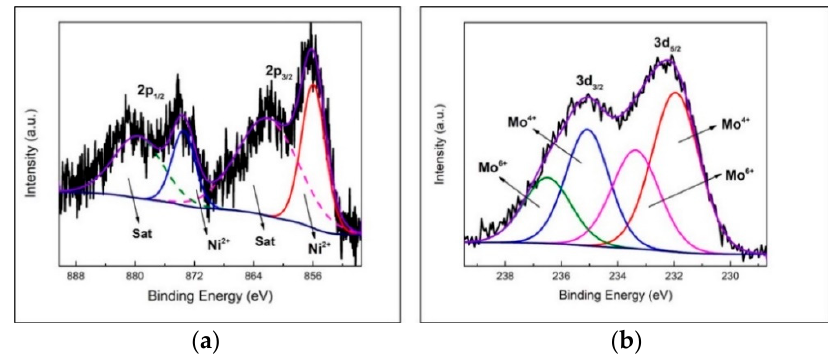
Figure 6. High ‐ resolution XPS spectra of ( a ) Mo 3d, ( b ) Ni 2p. Figure 6. High-resolution XPS spectra of ( a ) Mo 3d, ( b ) Ni 2p.